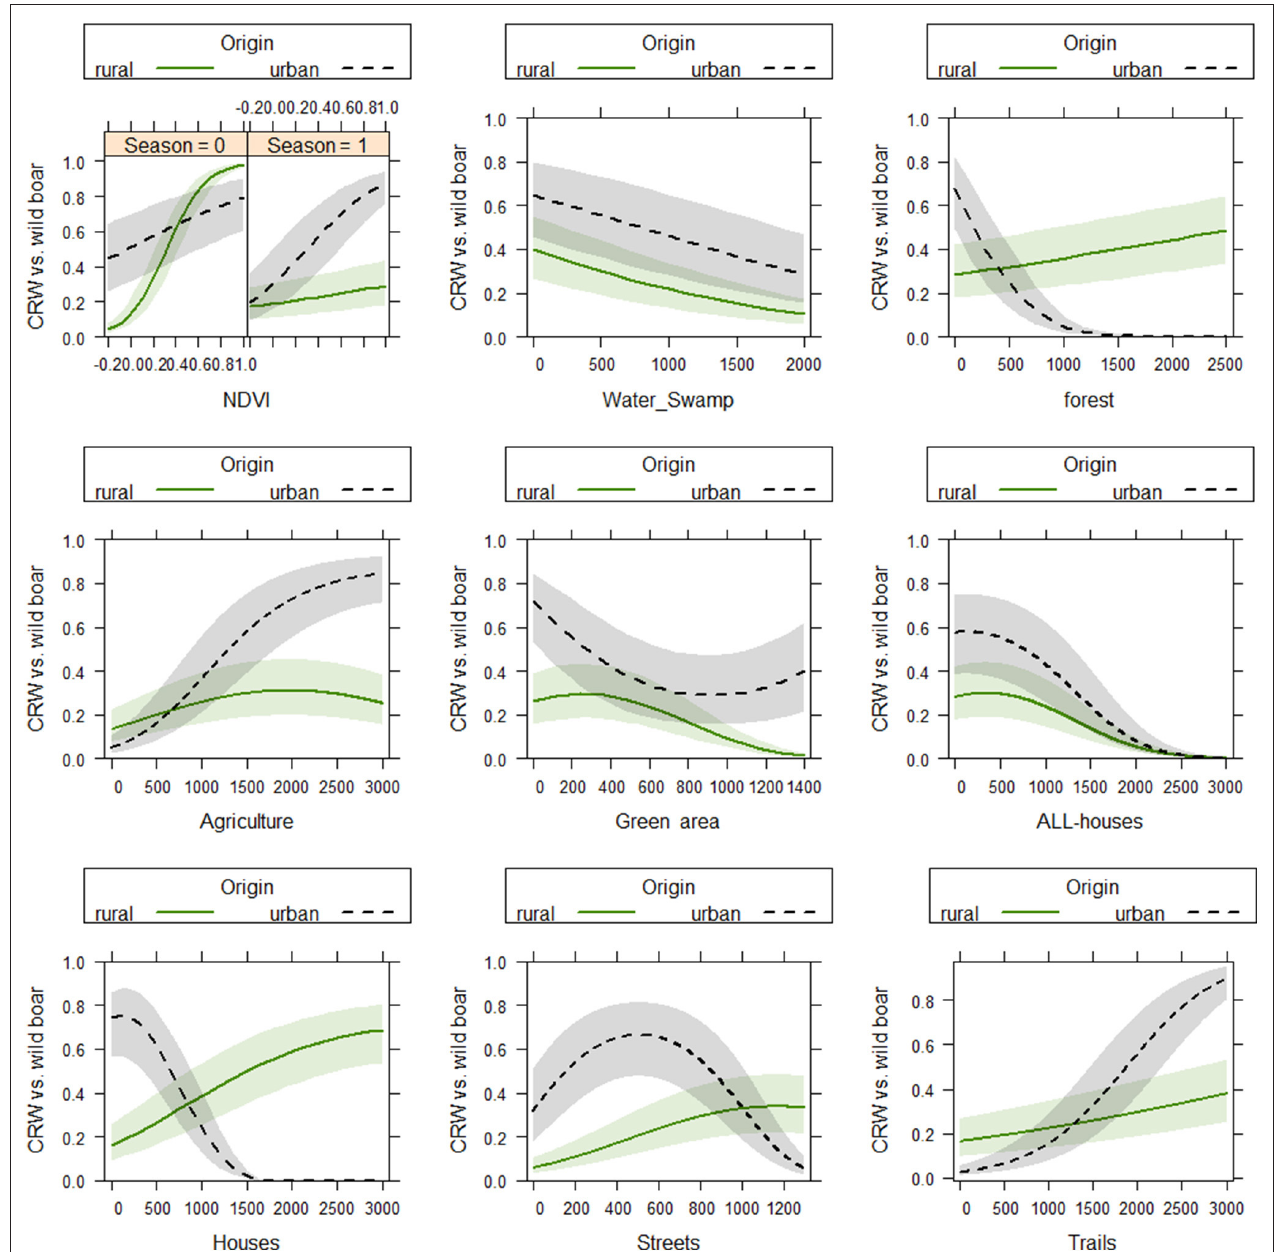
FIGURE 3 | Effects plot of generlized mixed models, testing the impact of distance to different landscape types and NDVI on habitat use of urban vs. rural wild boar in Berlin and Brandenburg between 2013 and 2015. For the comparison of use (1 = locations of WILD BOAR) and availability (0 = simulated movement tracks), generalized linear mixed models (GLMM) were run. The distance to 8 landscape variables (agriculture, forests, green area, houses, houses with garden, streets, trails, and water) and normalized difference vegetation index (NDVI) values were tested in interaction with the origin (urban, dashed black line and rural, solid green line). The NDVI was additionally entered as interaction term with the season (Season 0 = no vegetation/winter, Season 1 = vegetation /summer). The default cutoff is 0.17 because we used five times more correlated random walks than wild boar locations.